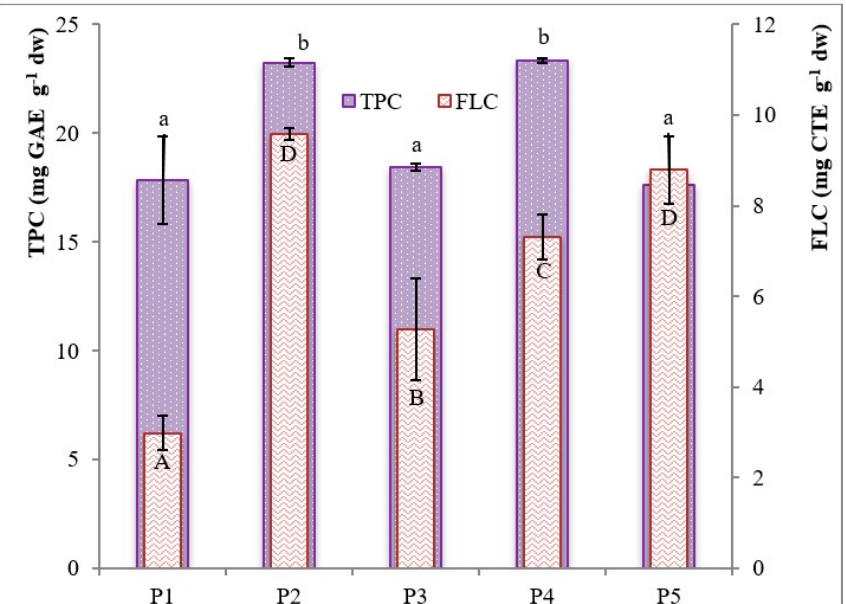
Figure 2. Total phenolic and flavan-3-ols content (mg g − 1 ) of five A. unedo fruit extracts (mean ± SD). Different letters indicate significant differences in the mean ( p < 0.05). TPC: total polyphenol content; FLC: flavan-3-ols content; GAE: gallic acid equivalents; CTE: catechin equivalents.